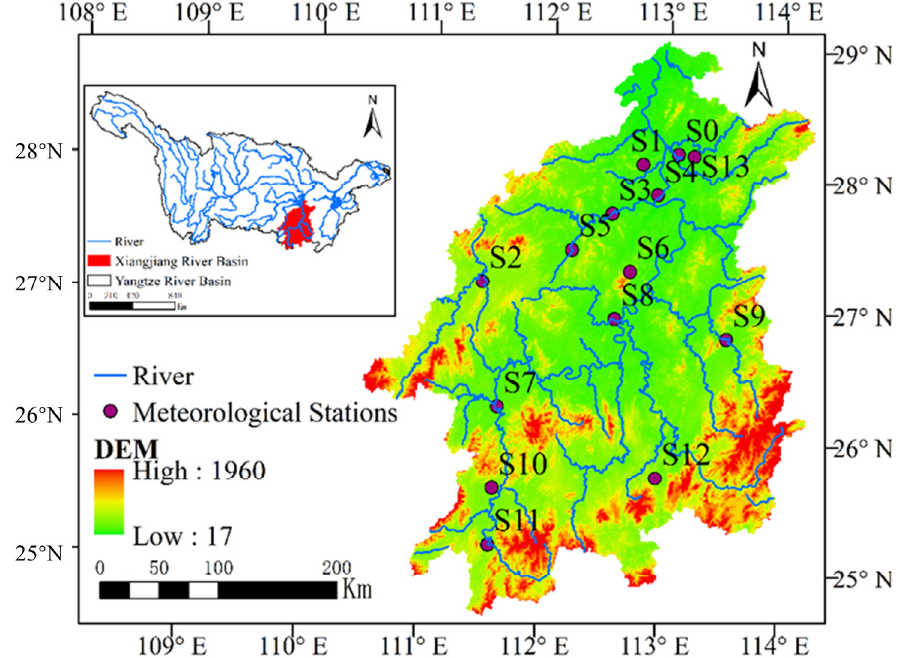
Figure 1. Geographical location of the study area and distribution map of meteorological stations. Table 1. Data information and